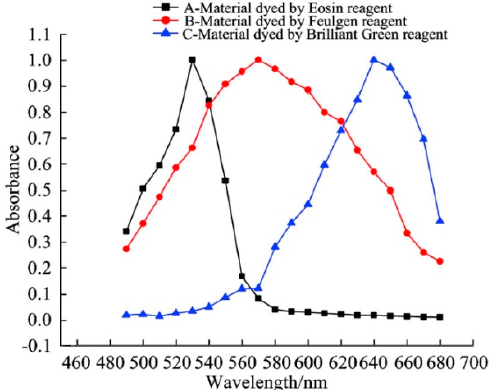
Figure 2. The absorbance curves of absorbent materials.